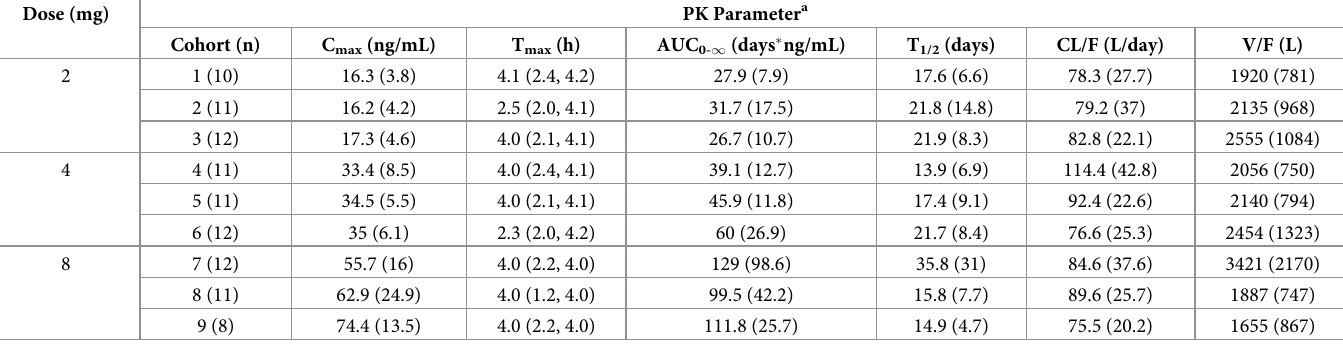
Table 3. Summary of PK parameters of moxidectin by dose and cohort (different disease severity). Dose (mg) PK Parameter a